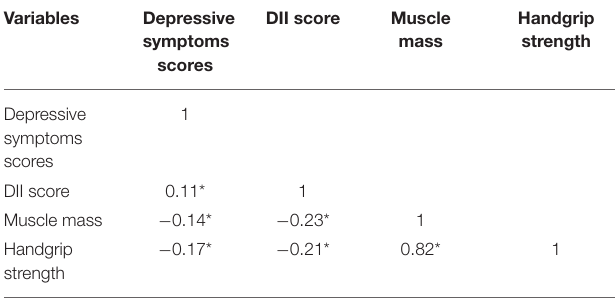
TABLE 2 | Correlations between